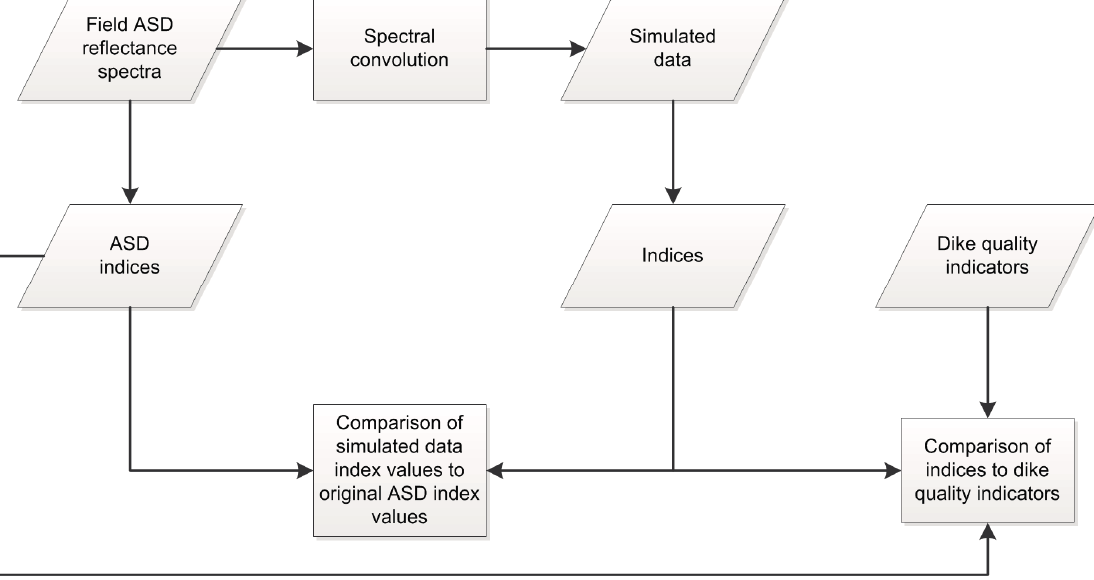
Figure 1. Summary workflow of the materials and methods used in this